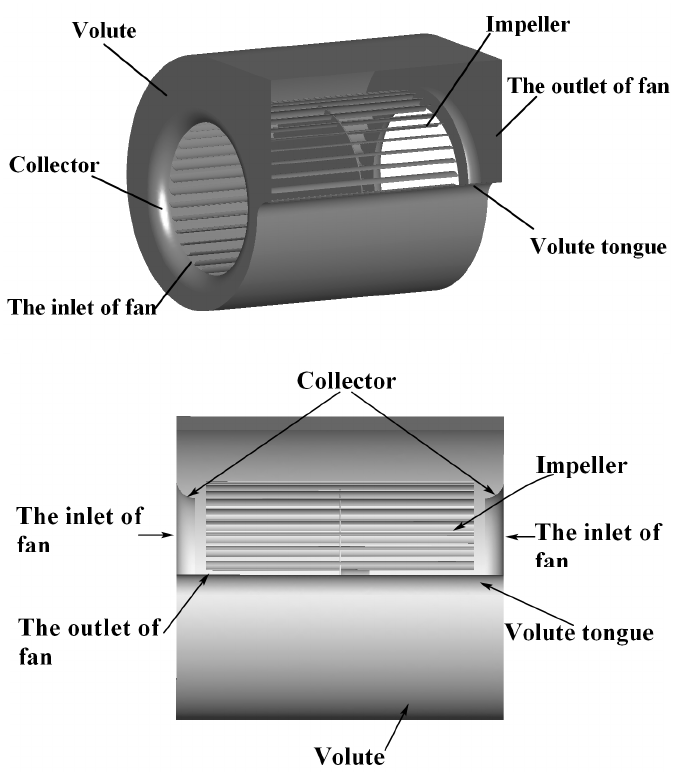
Figure 1 . Three-dimensional model of a centrifugal fan . Figure 1. Three-dimensional model of a centrifugal